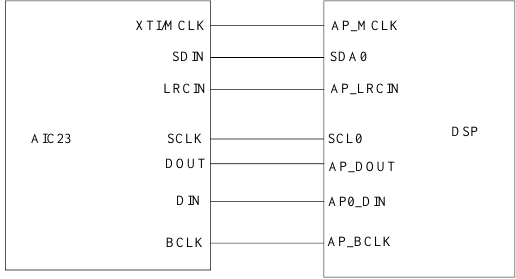
Figure 3. TLV320AIC23 and DSP chip connection structure